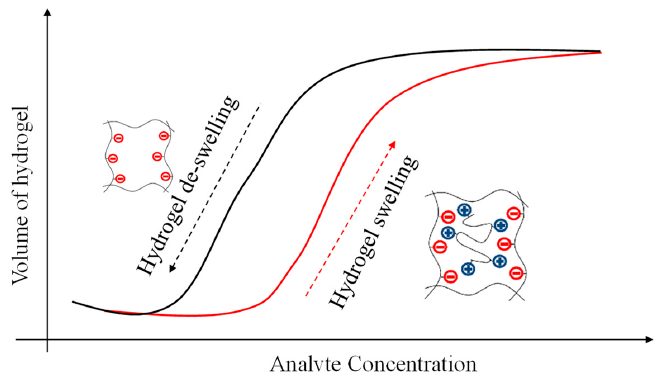
Figure 1. Schematic of a hydrogel functionalized with pendant negatively-charged molecules that attract or release positively-charged target analytes, resulting in physical, electrical, and chemical changes in the hydrogel.